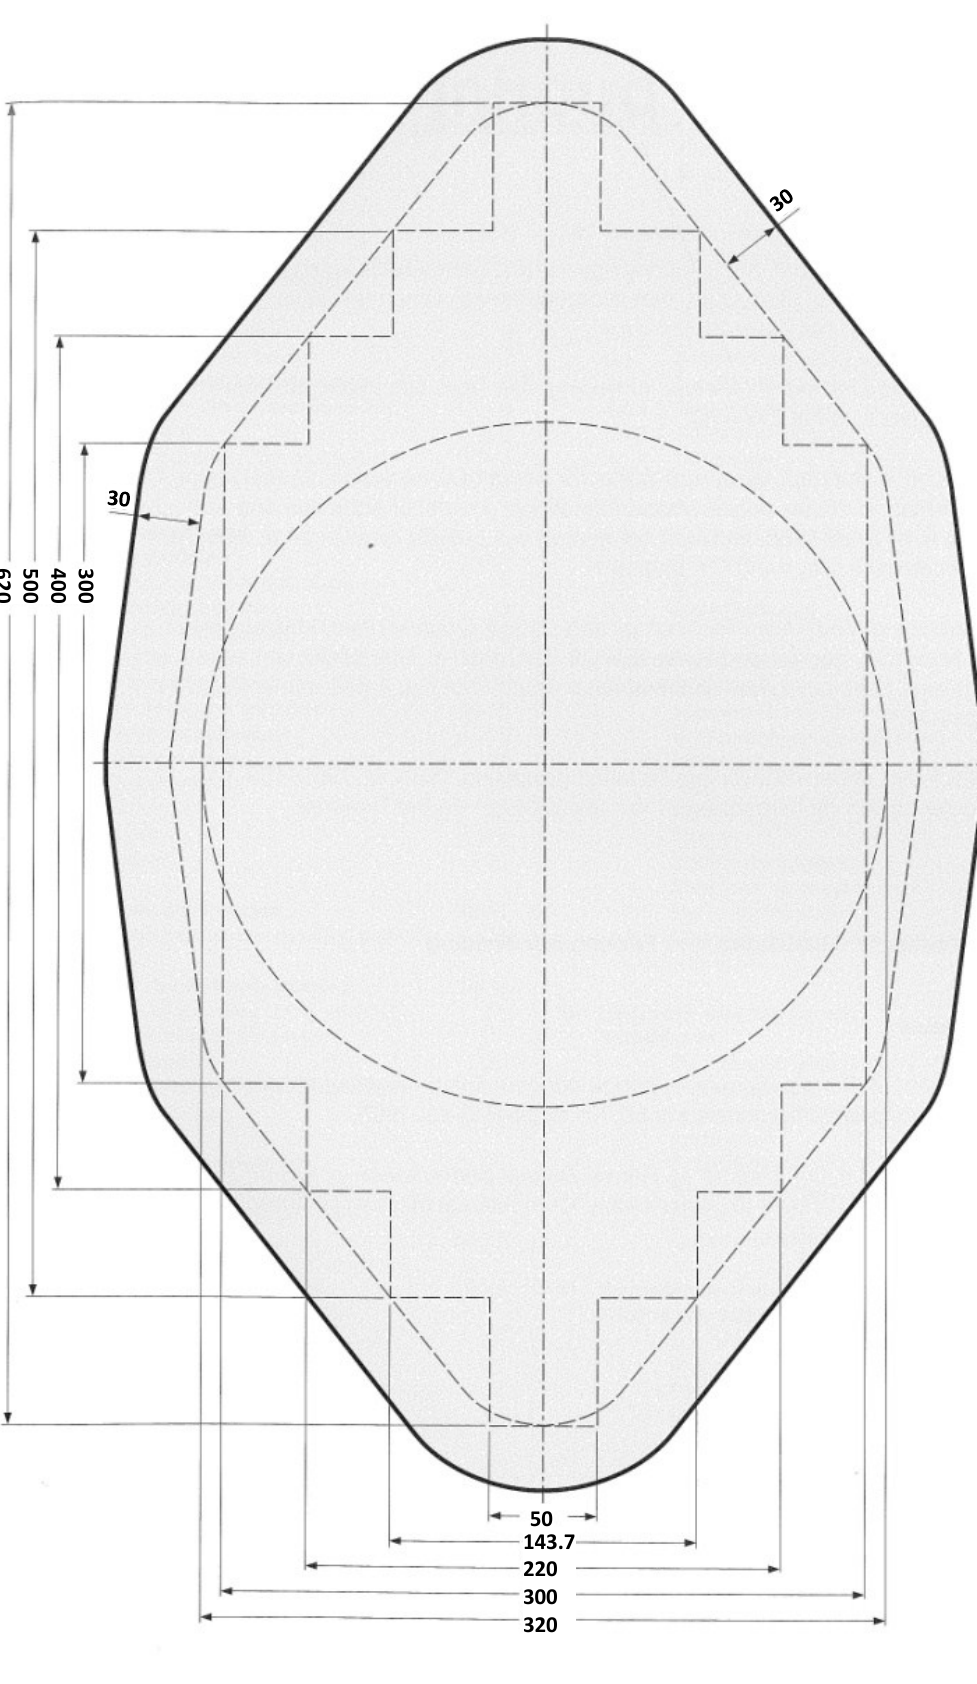
Figure 1. Die geometry (measures in